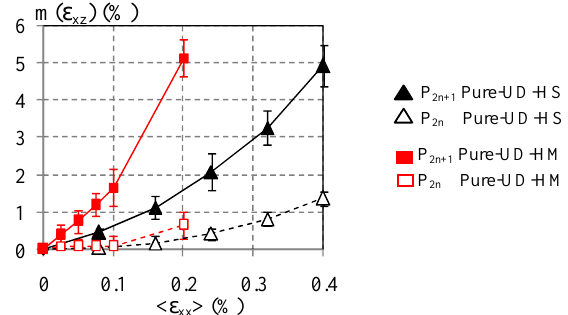
Fig. 9. Variation of m( e xz ) at the first interface as a function of the macroscopic applied strain < e xx > in pure-UD-HS and pure-UD-HM samples In the same way, DIC measurements were carried out on quasi-UD-HS laminate edges (Fig. 10a the 15°/-15° interfaces are named I , I and I ). In this laminate, the inter-layer matrix thickness 1 2 3 varies along each interface as well as the magnitude of e (Fig. 10b). The magnitude variation of e xz at I and I highlights that the thinner the interlaminar interfaces, the higher the shear strain 1 3